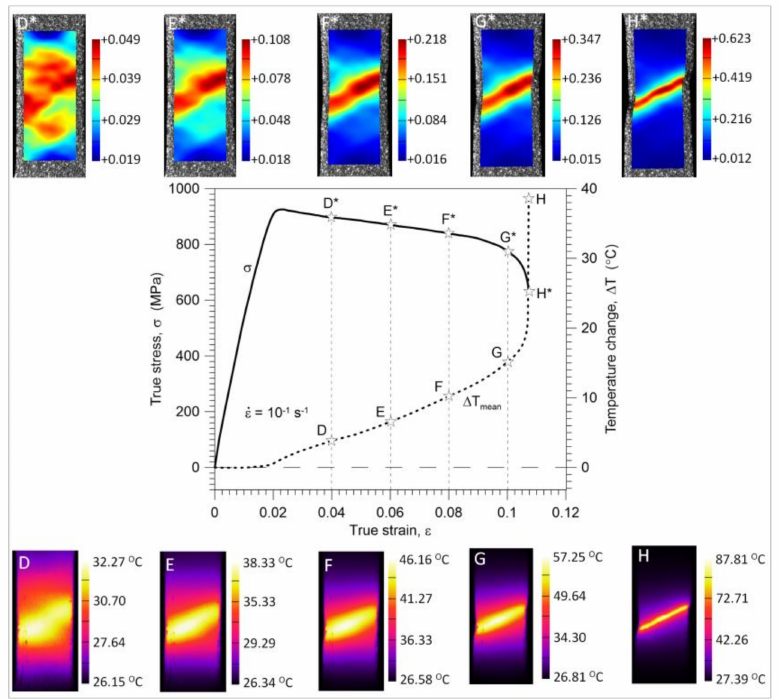
Figure 9. Stress σ and temperature change ∆ T mean versus strain ε completed by related DIC strain (above) and IR temperature (below) distributions for Gum Metal in tension at a strain rate of 10 − 1 s − 1